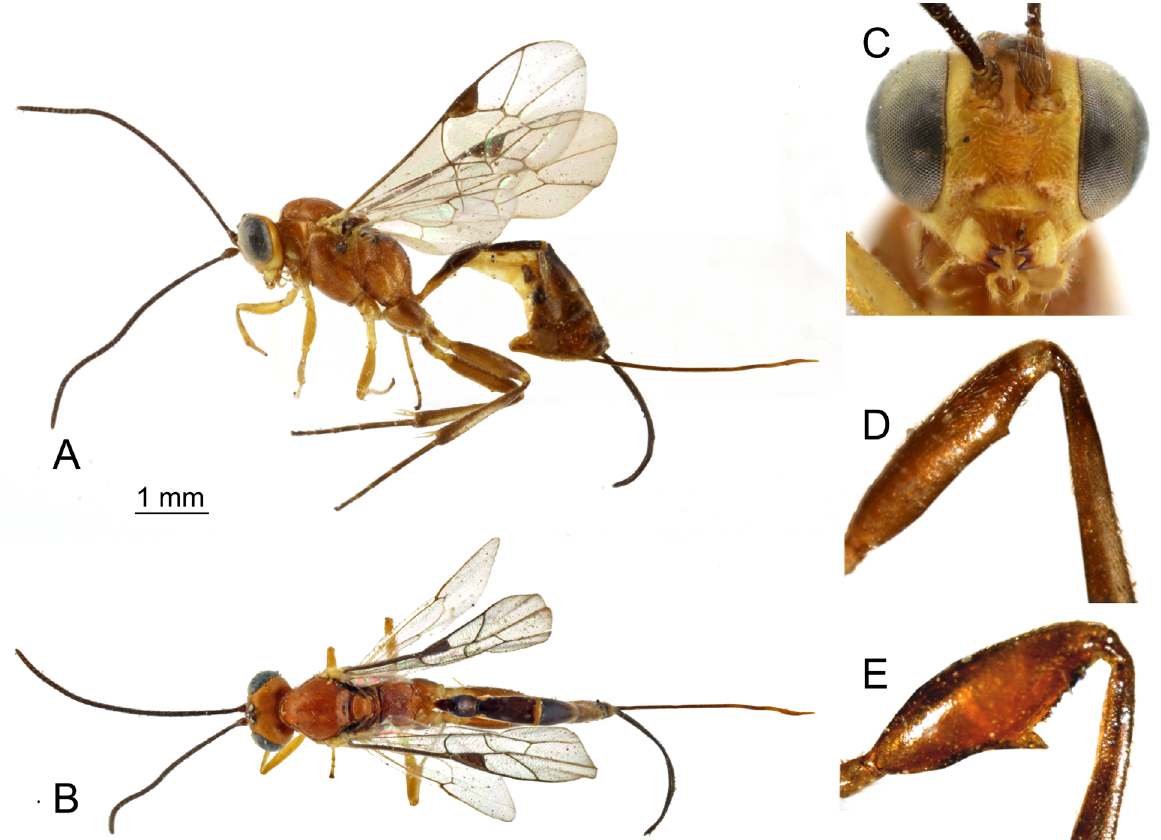
Fig. 14. Pristomerus roberti sp. nov. A . ♀, habitus, profile. B . ♀, habitus, dorsal. C . ♀, head, facial. D . ♀, hind femur, profile. E . ♂, hind femur,